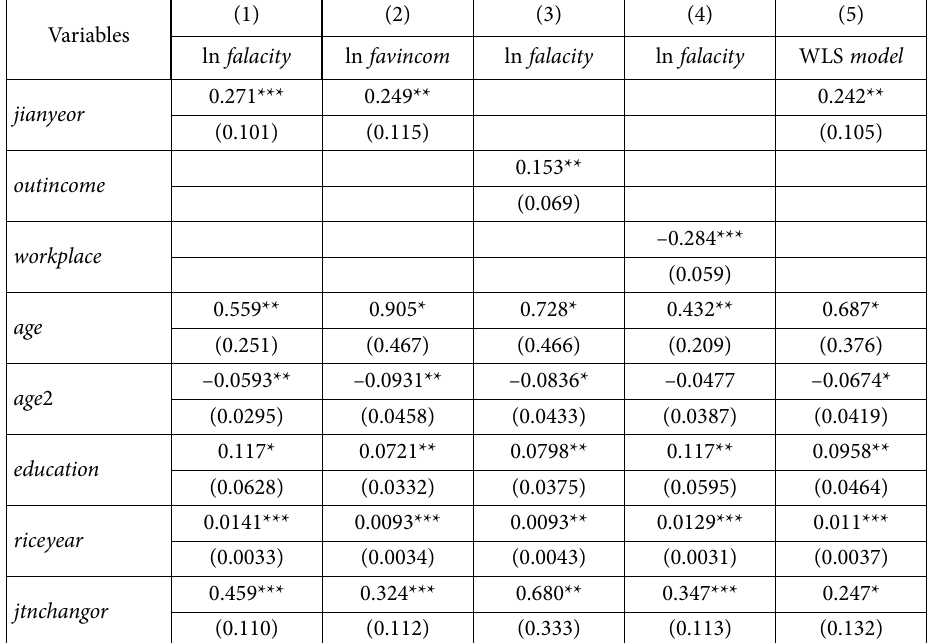
Table 2. The impact of non-agricultural part-time work of farmer households on agricultural labor productivity